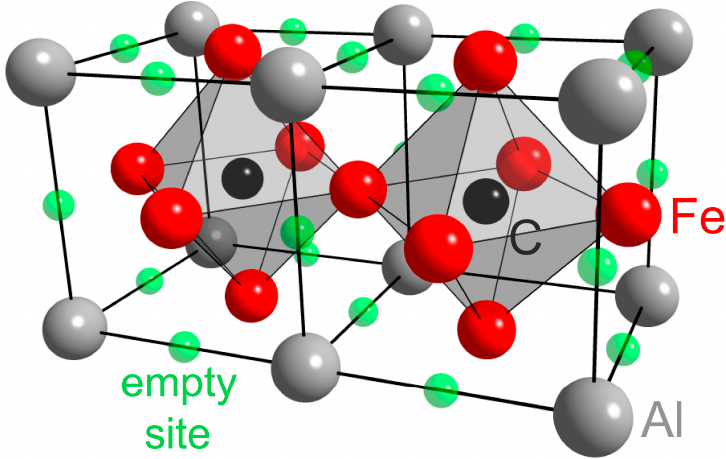
Figure 1. Crystal structure of Fe 3 AlC, a κ -carbide crystallizing in the E 2 1 type, shown as a 2 × 1 × 1 supercell. Grey, red, and black spheres denote Al, Fe, and C atoms, respectively. Green translucent spheres indicate the unoccupied octahedral sublattice sites.